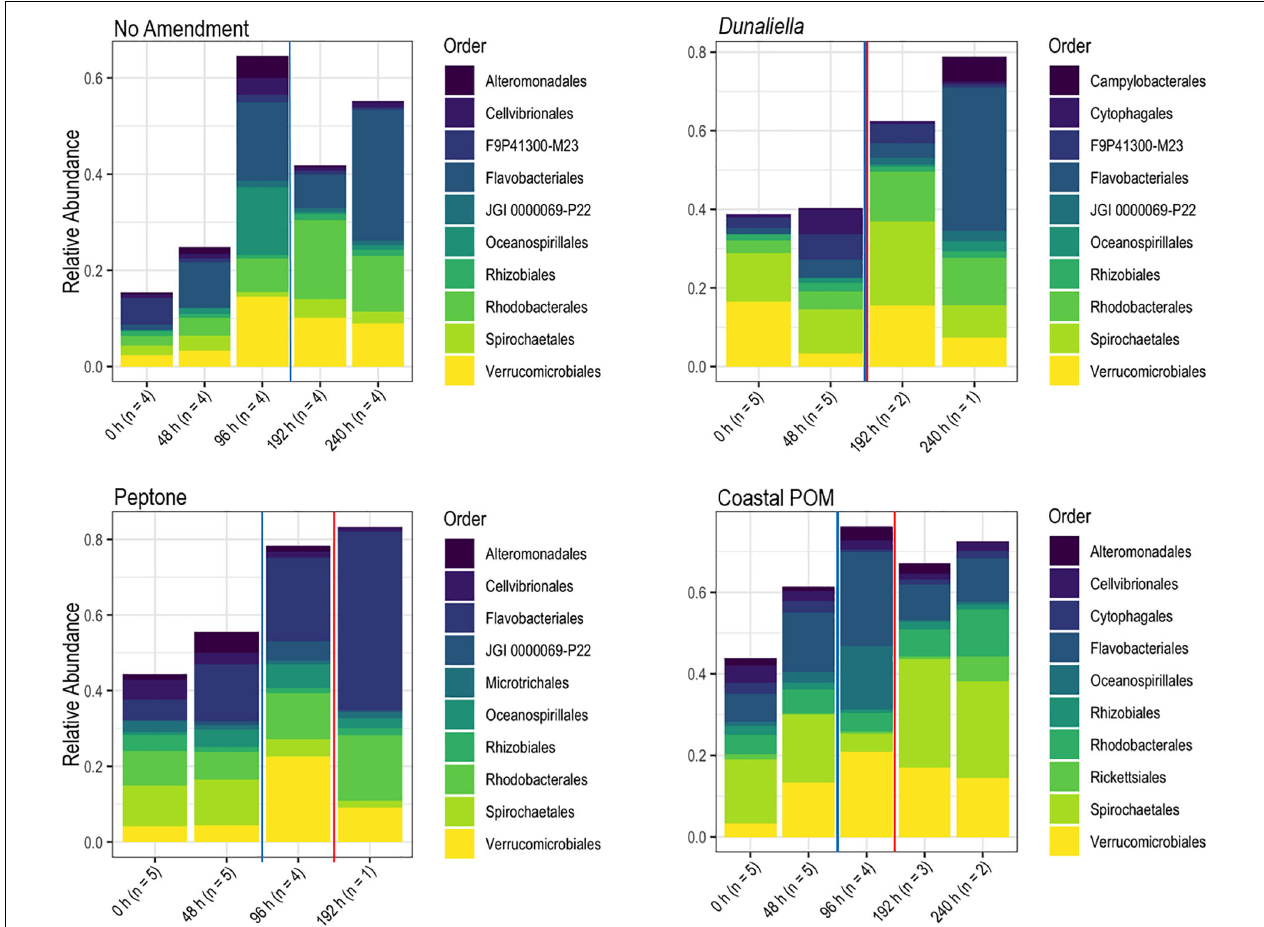
FIGURE 4 | Relative abundance of bacterial orders derived from P. ochraceus epidermal swabs. Specimens were enriched with the indicated organic material and sampled until lesion genesis. n values reflect the number of healthy specimens at each given timepoint. The solid blue line on each panel indicates when lesions first formed per treatment, and the solid red line on each panel indicates the mean lesion time within the